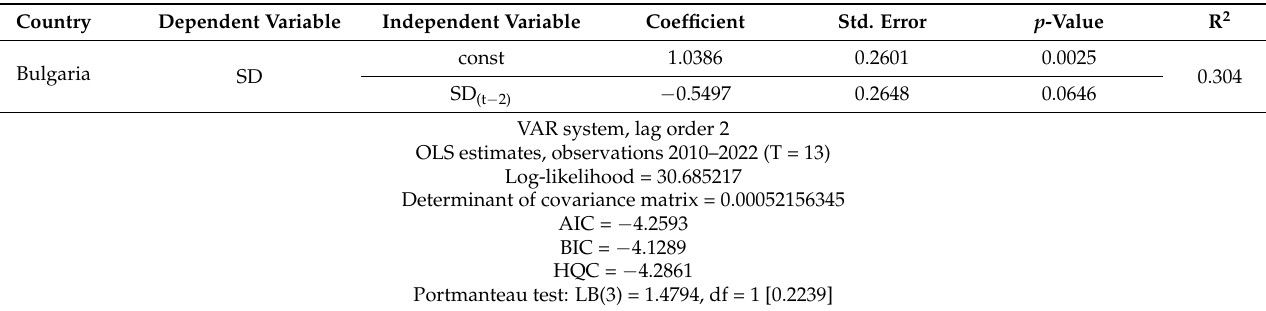
Table 4. Results of VAR models in the analyzed countries from 2008 to